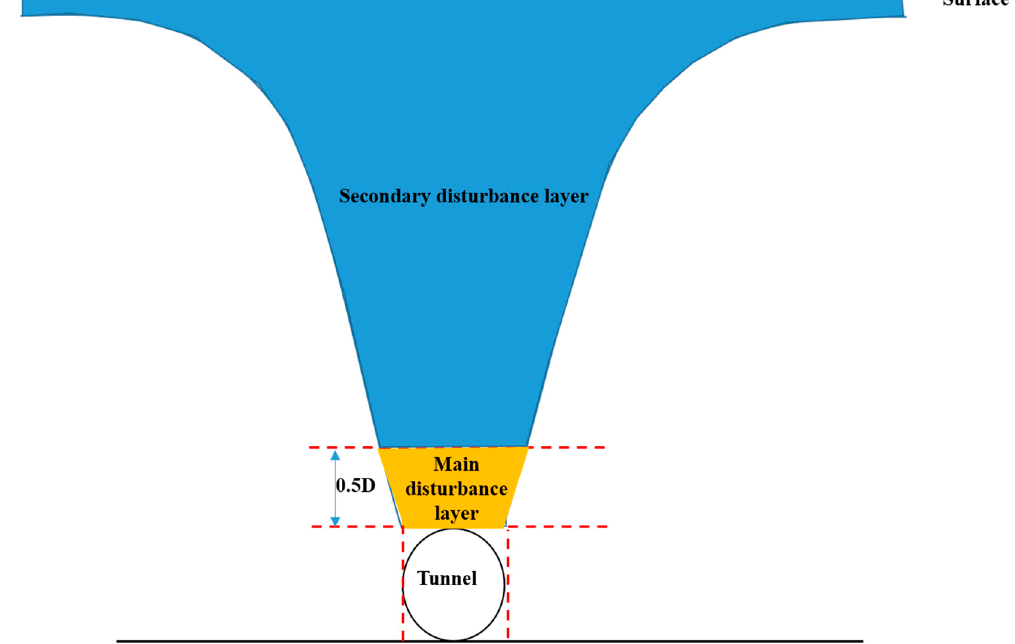
Figure 12. Horizontal disturbance layer division diagram.